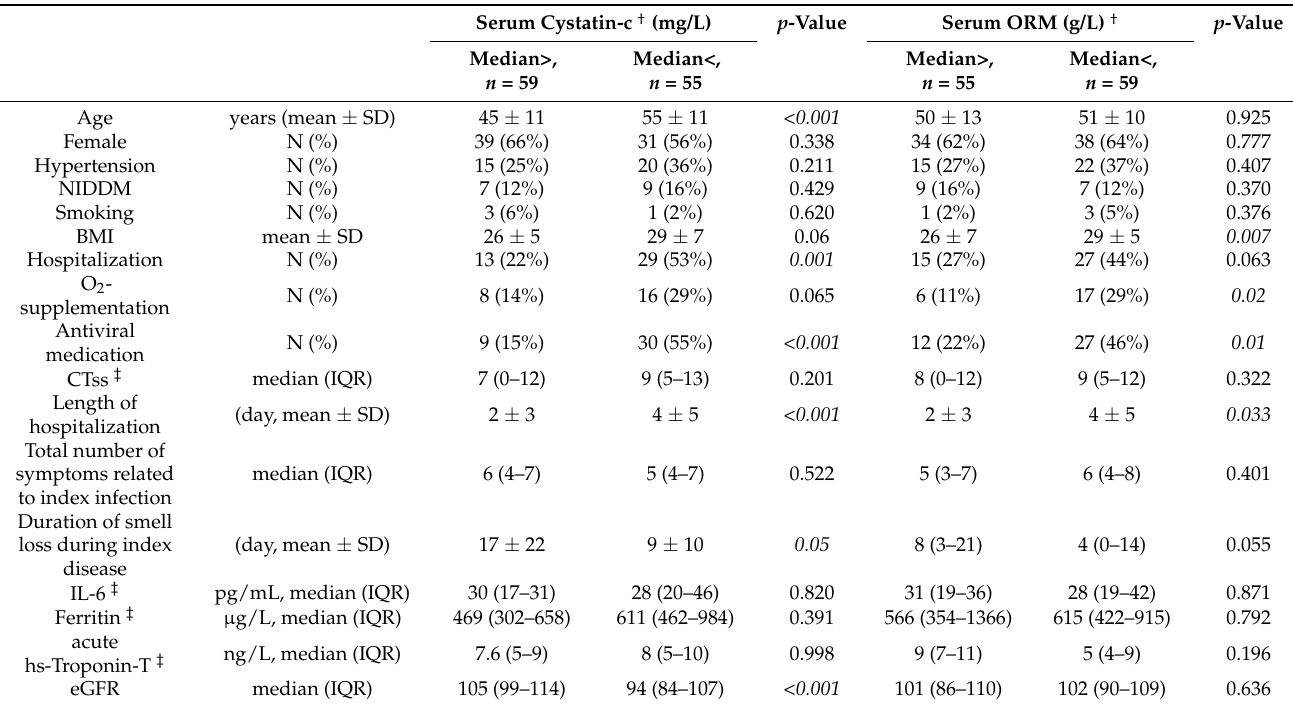
Table 1. Demographics and acute SARS-COV-2-infection-related variables in patients with higher and lower than the median serum cystatin-c and orosomucoid concentrations measured in long-COVID